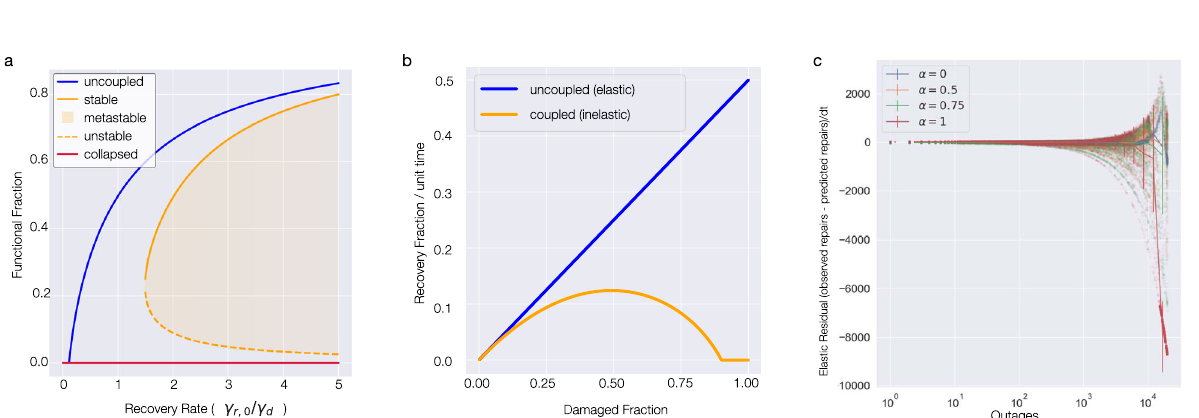
Fig. 3 Empirical evidence for recovery coupling. a Average outage duration and location of fl ooded roads during Tropical Depression Imelda. Delayed restoration occurred primarily around Beaumont and Northeast Houston, where most fl ooded roads were located. b Number of outages (orange) and fl ooded roads (blue) during Imelda. The shaded orange curve shows the middle quartiles of outages for the same times (hour and day) with no storm, offering a time control. c The recovery of outages during Imelda that were far ( ≥ 10 km) from fl ooded roads is well approximated by an elastic (linear) response. d Outages near (<10 km) fl ooded roads show substantial deviation from elastic behavior. The coloring encodes deviation from elasticity as in Fig. 2. e Fraction of unrepaired outages grouped according to their distance to the nearest fl ooded road. Using the Kaplan-Meier estimator, we fi nd statistically signi fi cant longer outage durations for outages closer to fl ooded roads. The spatial control of outages far from the storm and the temporal control of outages from the storm area in the 60 days before the storm, are comparable. In this case, we have taken proximity to damage as a proxy for the network effects of a road closure.